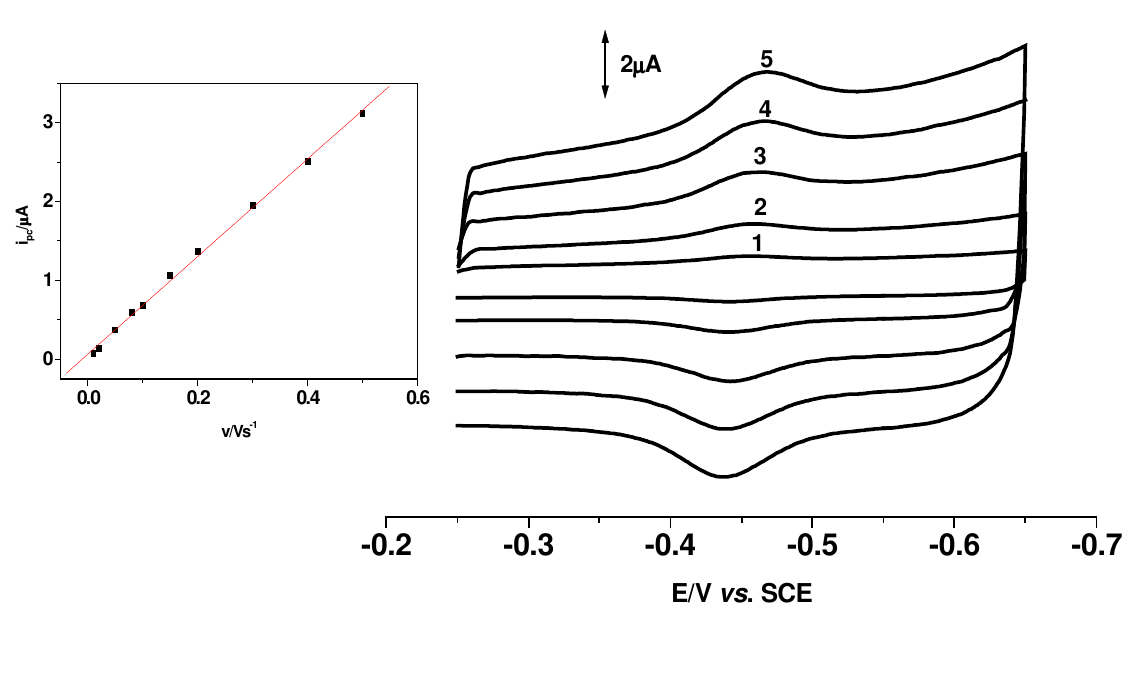
Fig.2. Cyclic voltammograms of glucose oxidase (1.0 ×10 -4 M) at a SWNT-modified gold electrode in a 0.05M phosphate buffer solution (pH 7.0) at scan rates of (1) 0.02, (2) 0.05, (3) 0.10, (4) 0.15, (5) 0.20 Vs -1 . The inset is a plot of the reduction peak current i